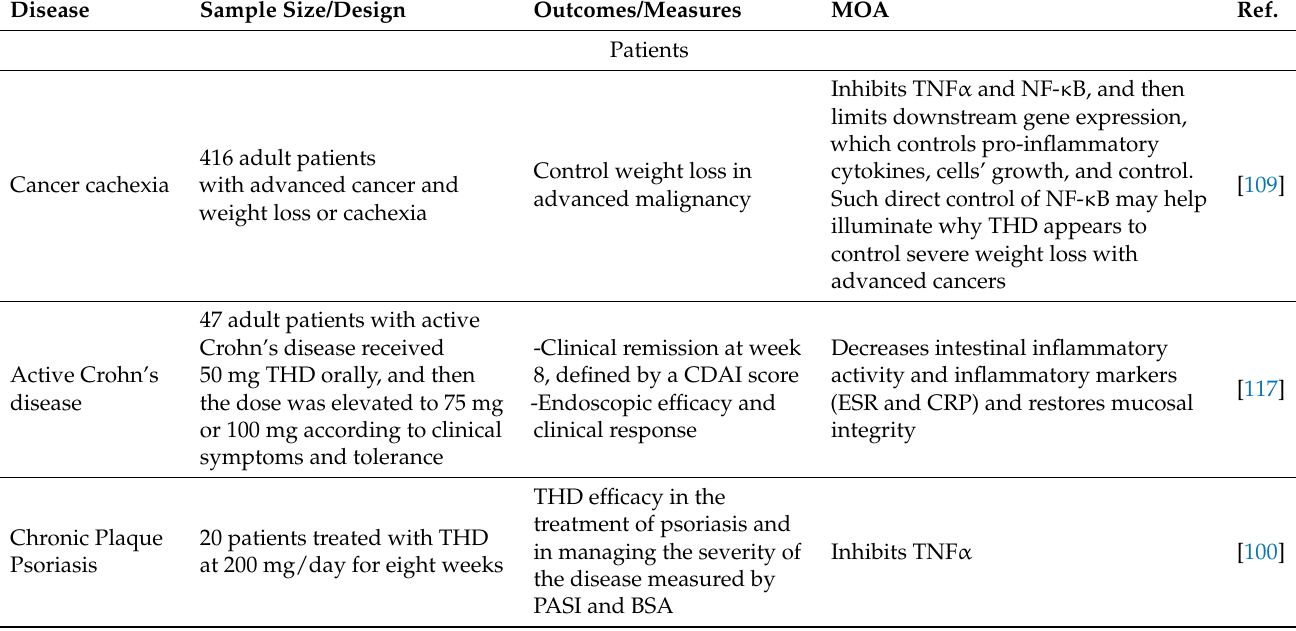
Table 1. Thalidomide mechanism of action in